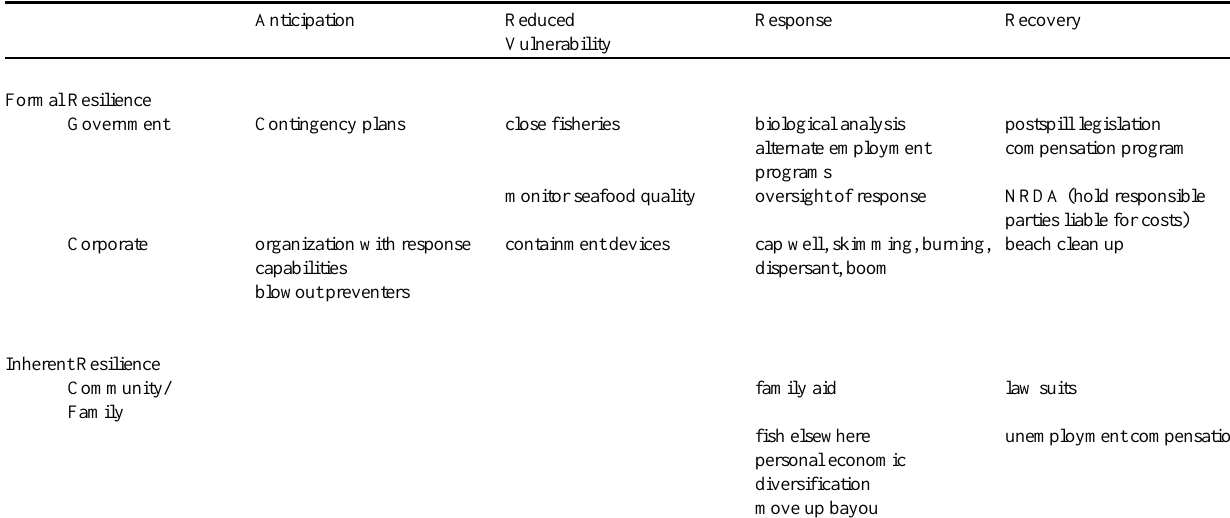
Table 3 . Post-1972 oil spill